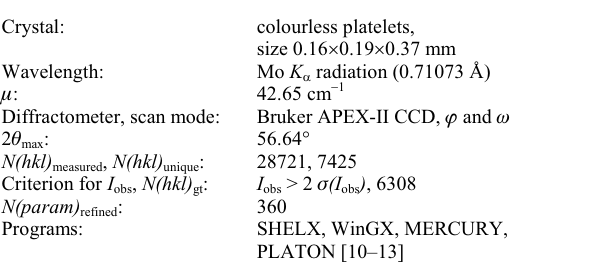
Table 1. Data collection and